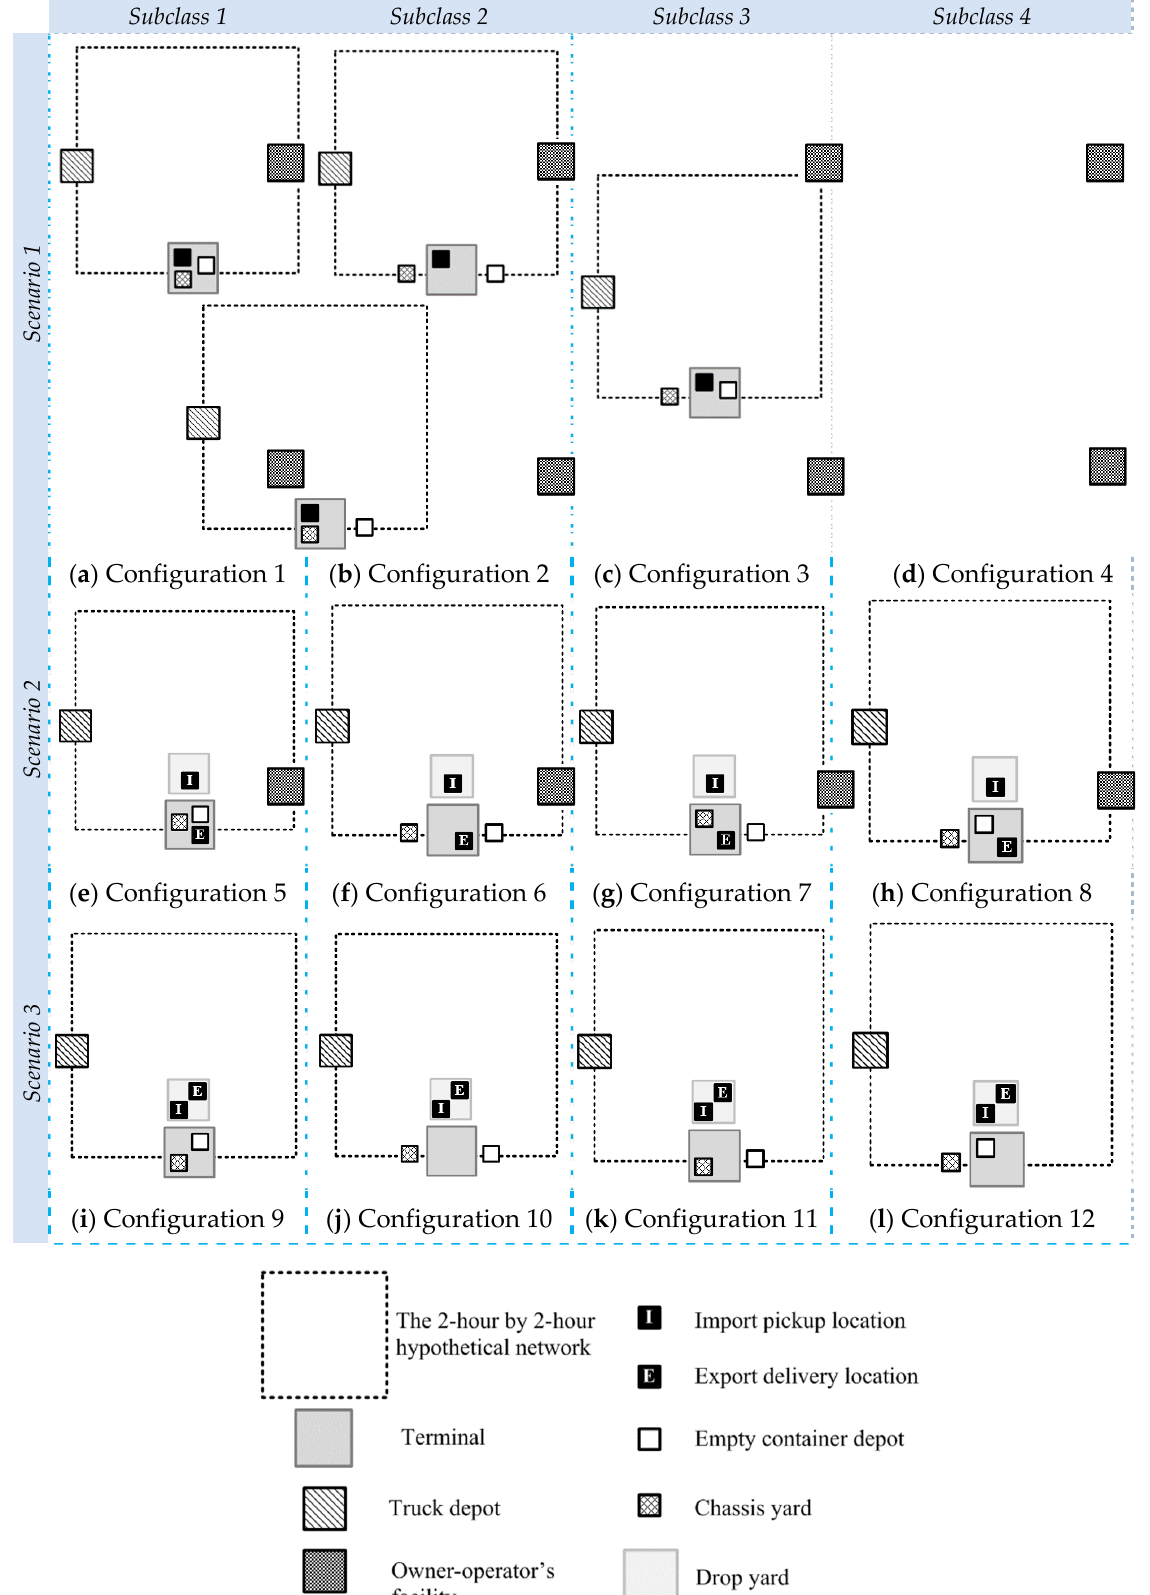
Figure 4. Location of the marine terminal and second-tier facilities considered in